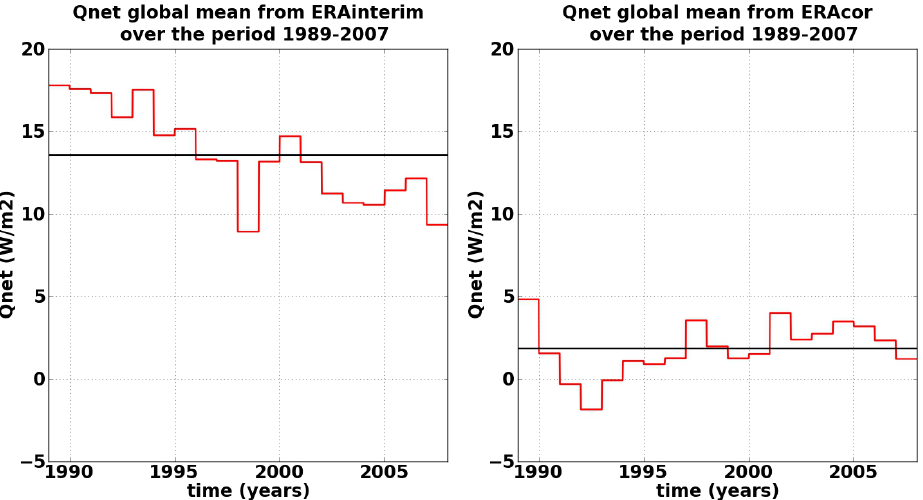
Fig. 6. 1989–2007 time series of global net heat fluxes monthly means (in red) computed with ERAi variables (left) and ERAcor variables (right). The black lines represent the global mean of the net heat flux over the whole 1989–2007 period.